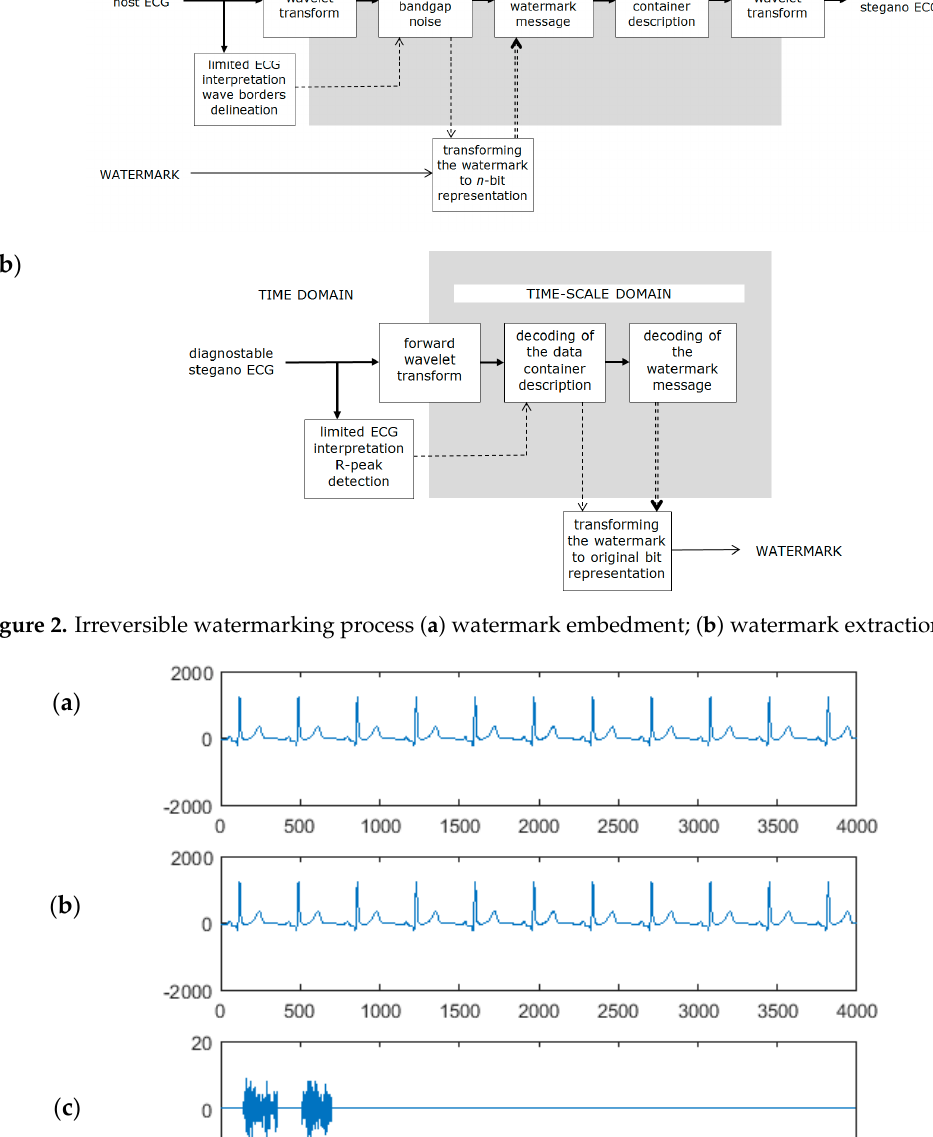
Figure 3. Signals in irreversible watermarking (in this example: CSE MA001, lead I, sym6 wavelet, textual watermark in 2-bit representation): ( a ) clean ECG (electrocardiogram signal); ( b ) watermarked ECG and ( c ) difference due to watermarking (the amplitude scale is 100 times lower); a 47 character watermark requires 188 2-bit samples and has been divided into two data containers of adjacent heartbeats.